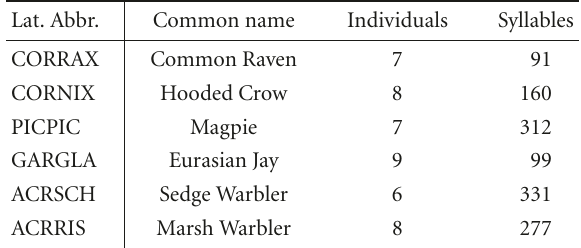
Table 2: 1st set of bird species used for recognition in this work. The last column indicates the total number of syllables.